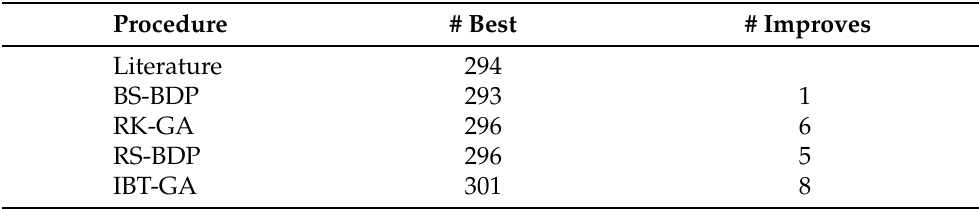
Table 2. Results of the procedures applied to the instance set (composed of 302 instances). For each procedure, the number of instances in which the algorithm provides the best solution (column #Best) or improves upon the best-known solution in the literature (column #Improves) are